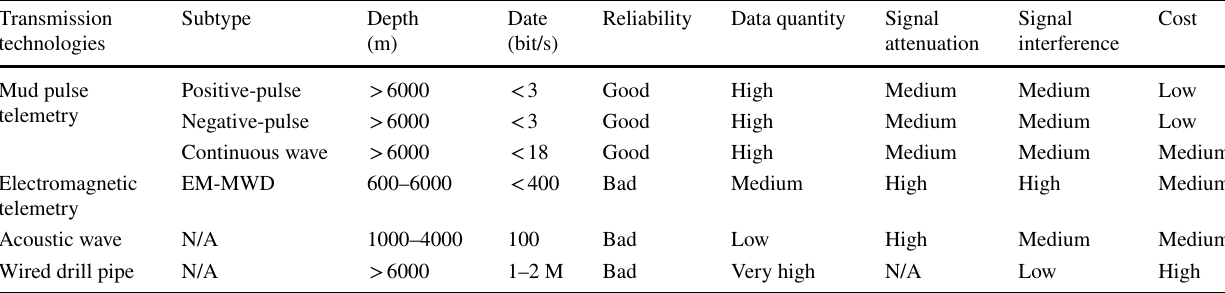
Table 4 Performance of different MWD technologies, after Ma et al. (2016) and Mwachaka et al. (2019) Transmission